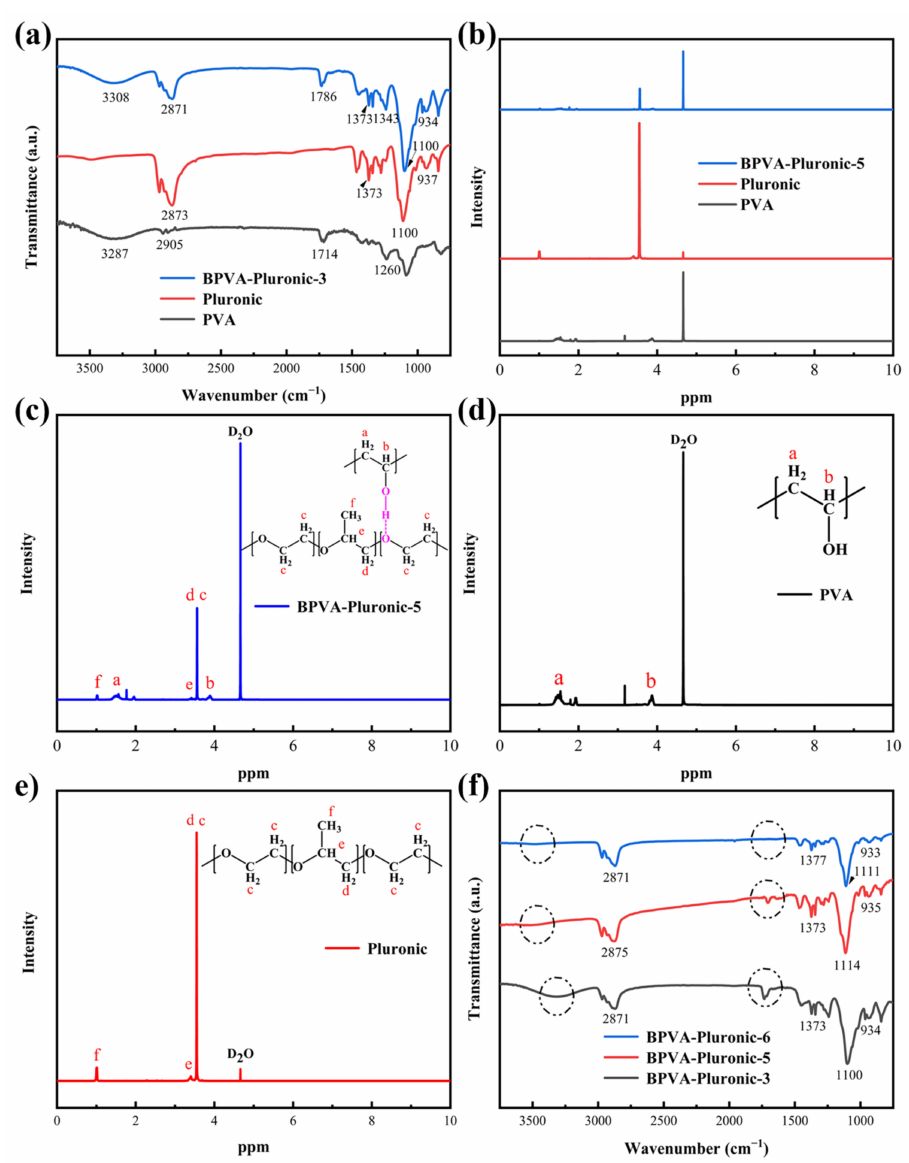
Figure 2. ( a ) The FTIR spectra of PVA, Pluronic and BPVA-Pluronic-3 hydrogel. ( b ) 1 H NMR spectra of ( c ) BPVA-Pluronic-5 hydrogel, ( d ) PVA, ( e ) Pluronic. ( f ) The FTIR spectra of BPVA-Pluronic hydrogels with various weight ratio of PVA and